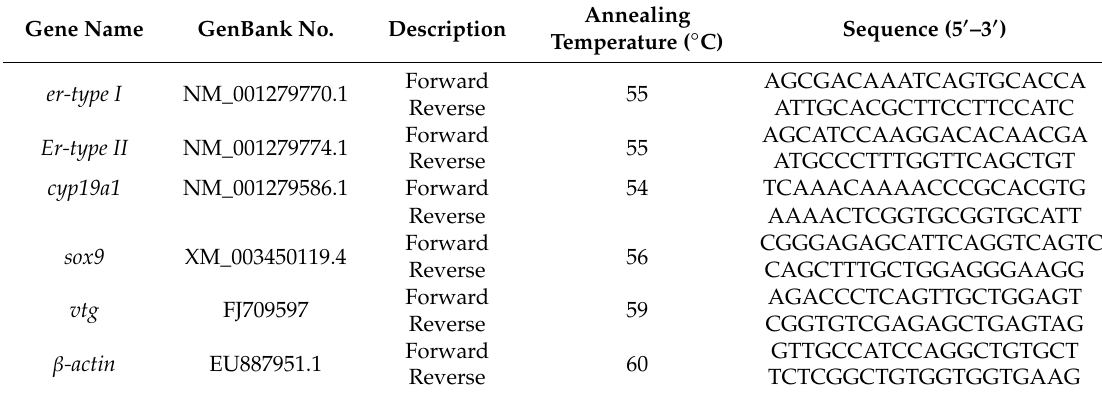
Table A1. Primers used for quantitative real-time